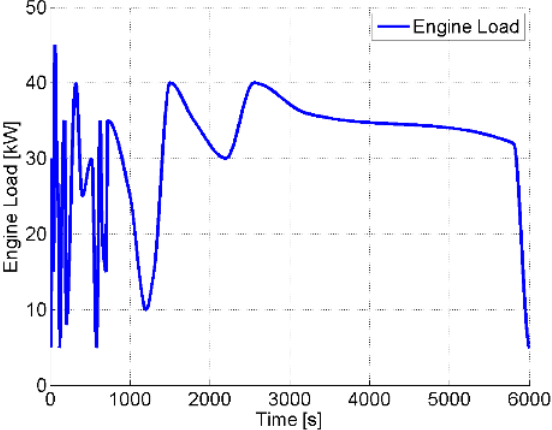
Fig. 6. Engine power in a course of